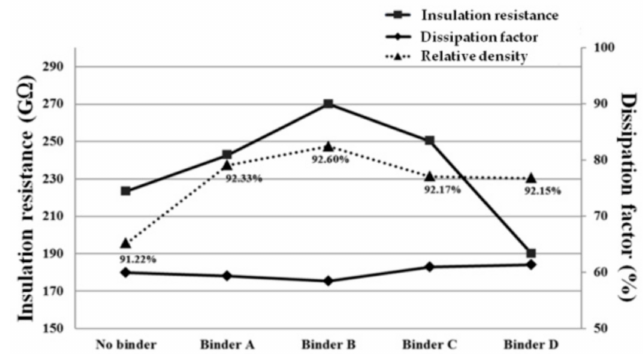
Figure 8. Insulation resistances, dissipation factors (tan δ ), and relative densities of the 0.1 wt.% Dy 2 O 3 -doped 0.98BaTiO 3 -0.02(Ba 0.5 Ca 0.5 )SiO 3 specimens sintered at 1320 ◦ C for 1 h with different